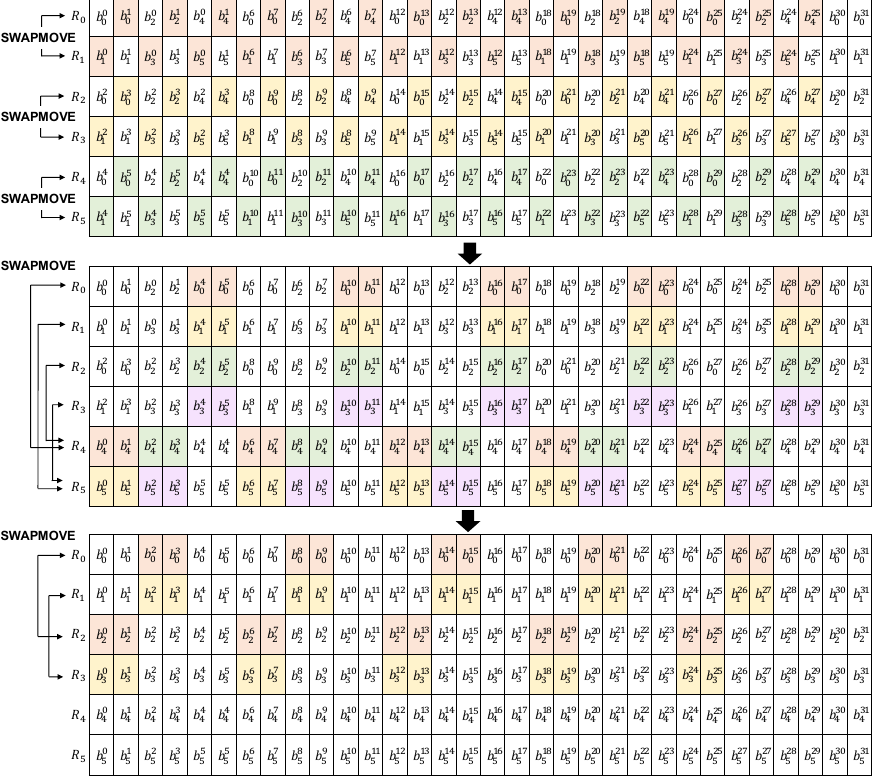
Figure 2. SWAPMOVE is used as the last step in the proposed technique to represent SPEEDY in a bit-slicing format. Bits in the colored part of the two registers are swapped. A block of 6 bits is expressed as b i , where i is the index of the block, and j is the position of the j